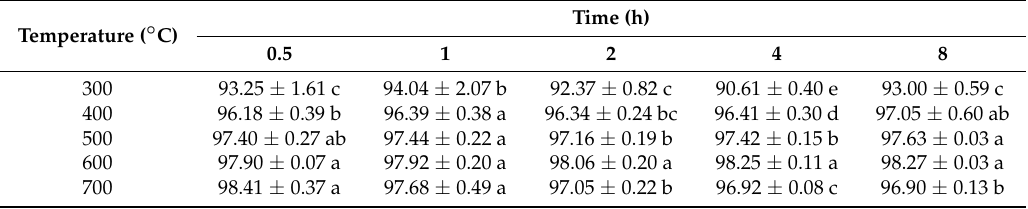
Table 3. The stabilization efficiency (%) of copper in soils by calcination